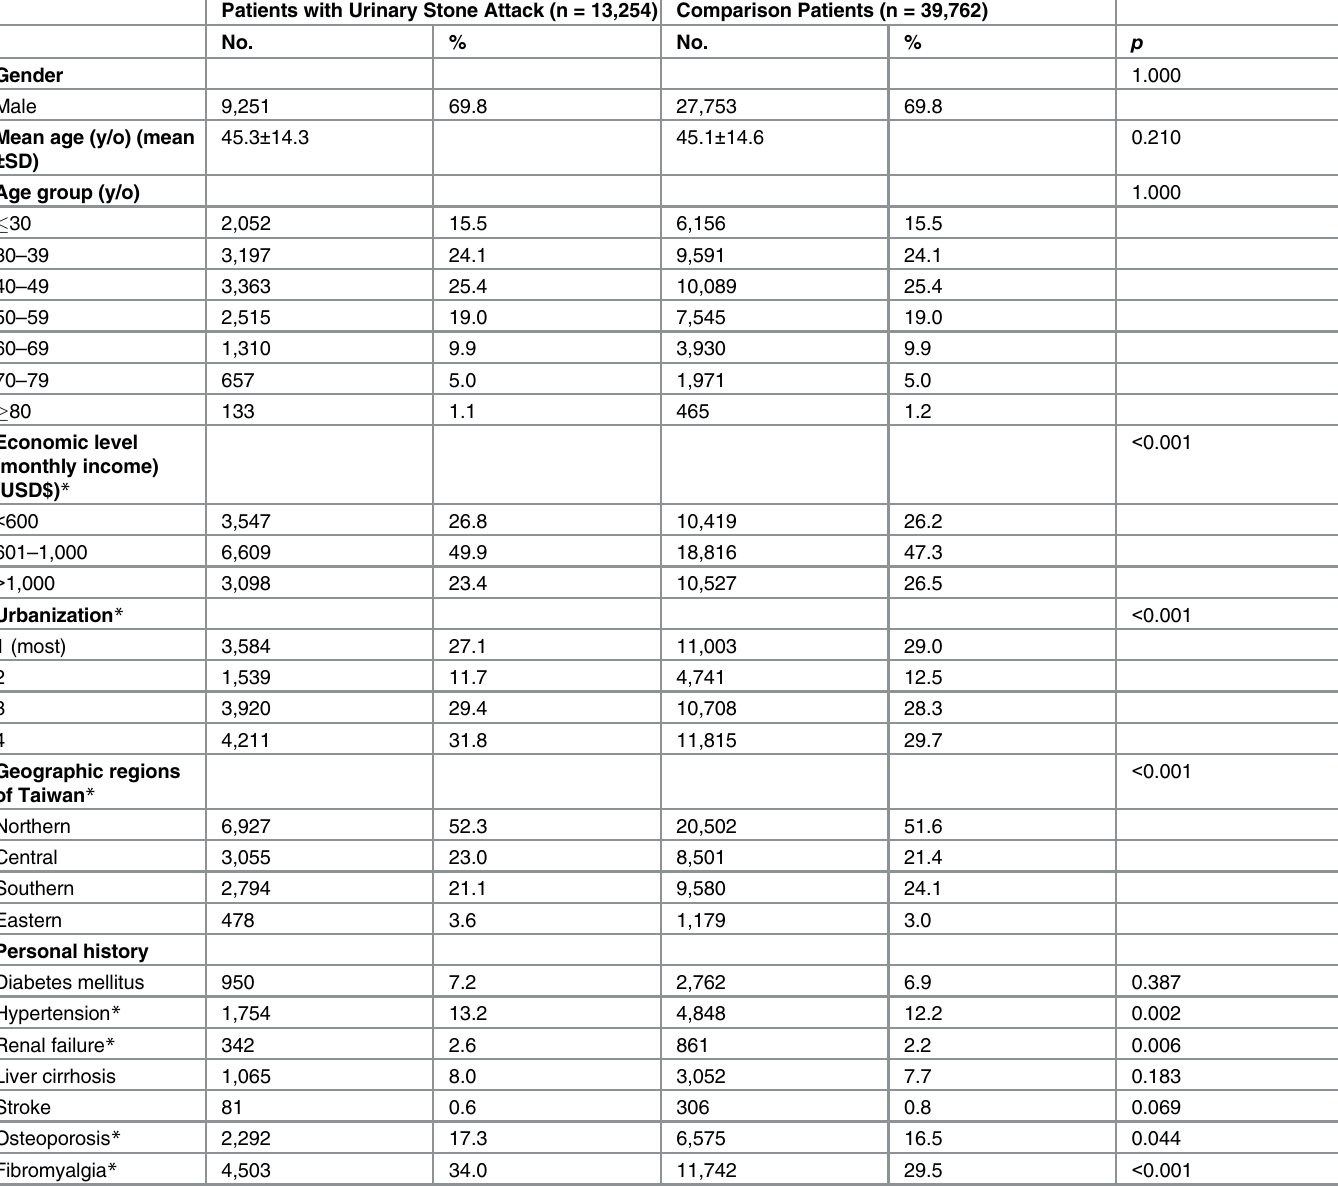
Table 1. Characteristics and personal histories between patients with urinary stone attack and comparison